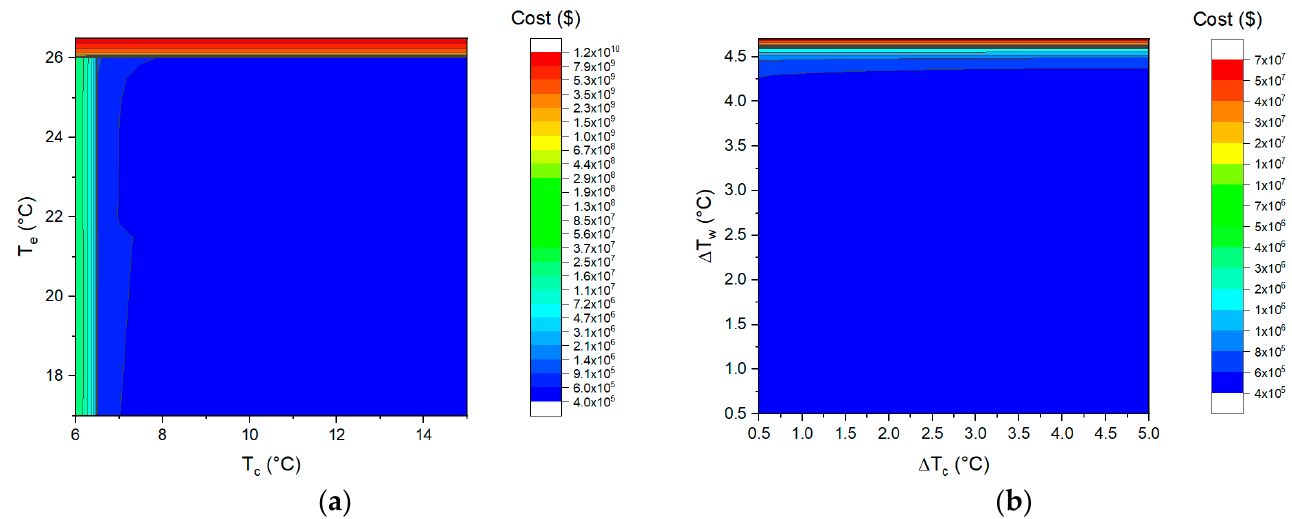
Figure 11. The effect of ( a ) evaporating and condensing temperature and ( b ) pinch-point temperature differences on the investment cost.